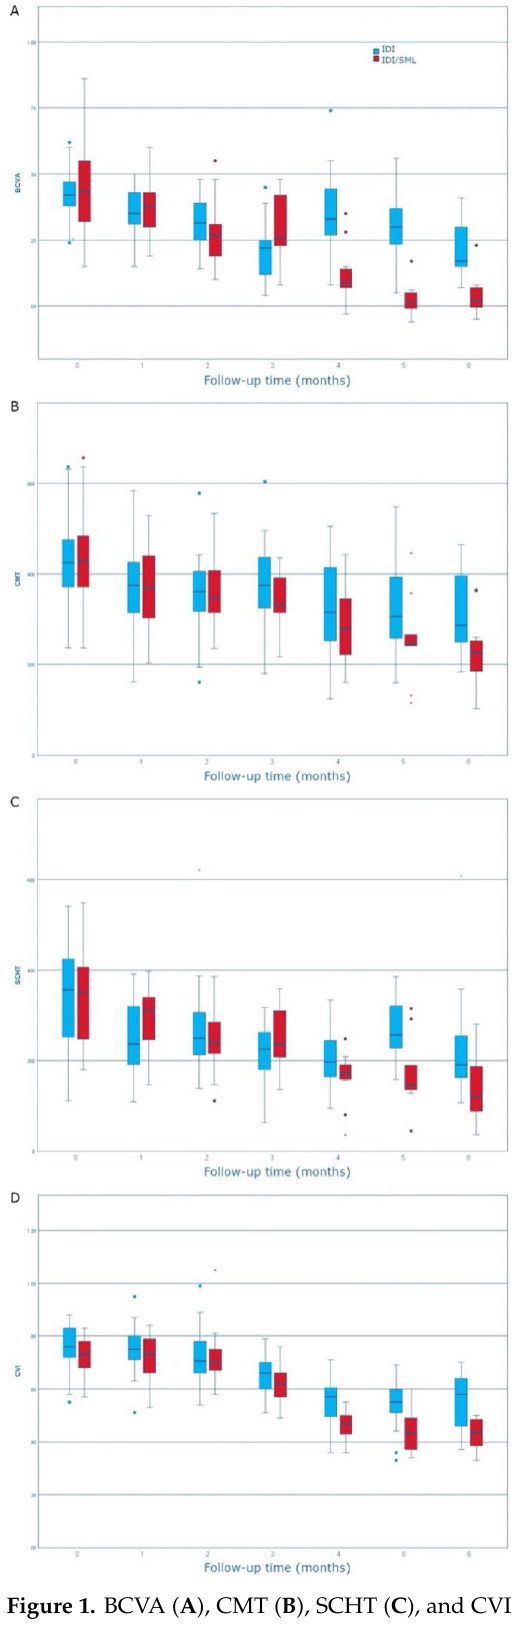
Figure 1. BCVA ( A ), CMT ( B ), SCHT ( C ), and CVI ( D ) variation over time in the two groups. The p - values indicate the results of the General Linear Model for Repeated Measures linear trends of time-group effect.